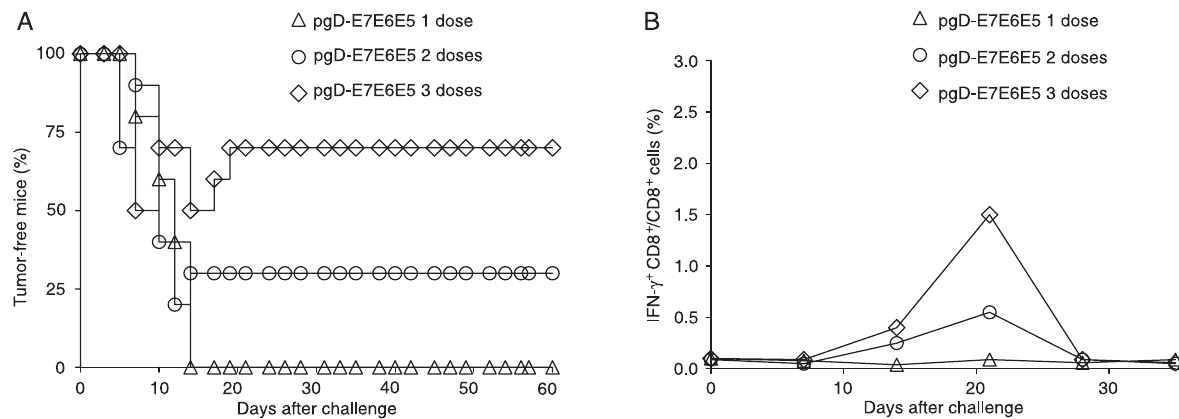
Figure 2. Therapeutic anti-tumor effects and E7-specific CD8 + T cell responses in mice immunized id with pgD-E7E6E5. A , Thera- peutic anti-tumor effects in mice previously inoculated with TC-1 cells and immunized with one, two or three doses of pgD-E7E6E5 administered with a gene gun. B , Detection of E7-specific CD8 + T cells in pooled PBMCs from mice inoculated with TC-1 tumor cells and immunized with one, two or three doses of pgD-E7E6E5 delivered via the id